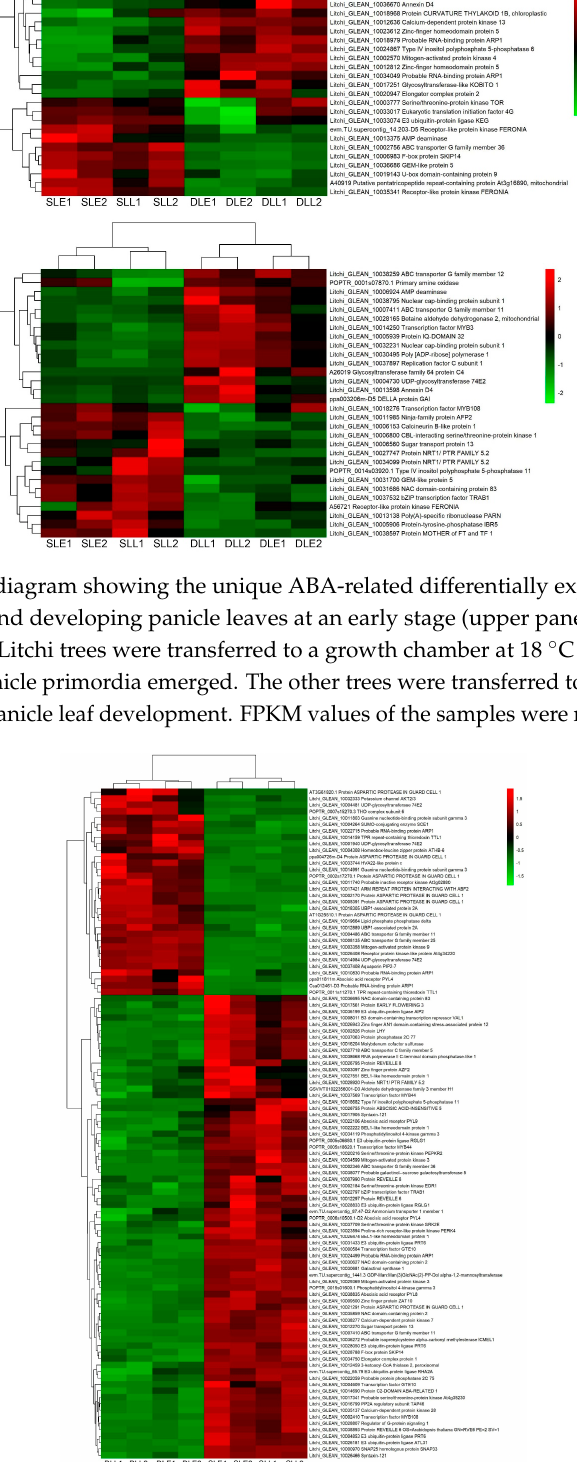
Figure 5. Heat map diagram showing the ABA-related differentially expressed genes (DEGs) between senescing and developing panicle leaves simultaneously expressed at early and later stages. Litchi trees were transferred to a growth chamber at 18 ◦ C to induce panicle leaf senescence when panicle primordia emerged. The other trees were transferred to a growth chamber at 26 ◦ C to encourage panicle leaf development. FPKM values of the samples were normalized to